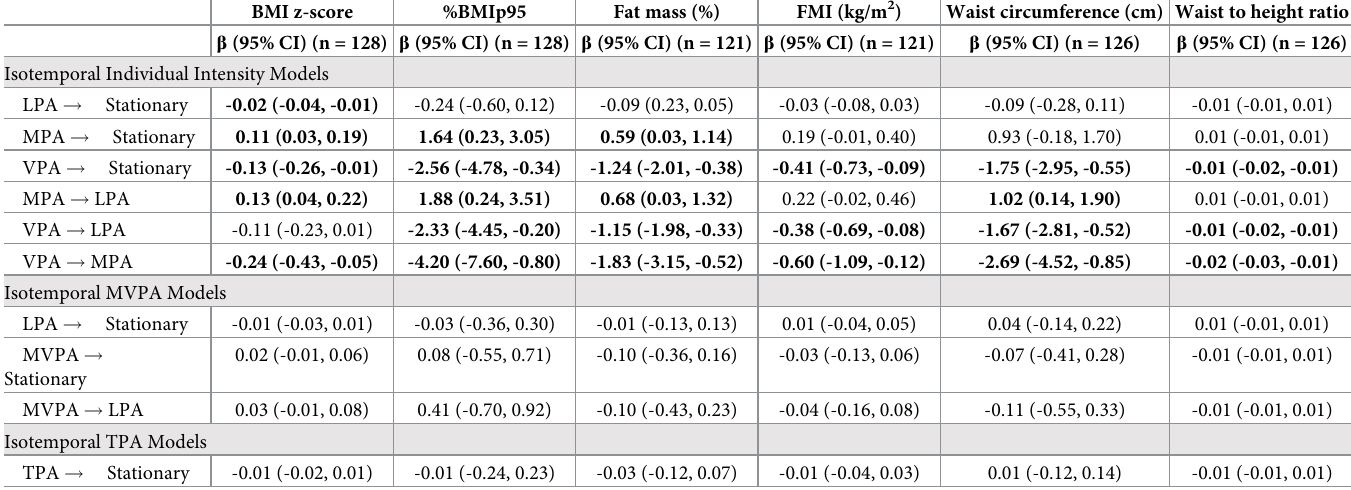
Table 2. Isotemporal substitution of movement behaviors with adiposity health indicators in preschool children with overweight and obesity participating in the baseline assessment of the TX CORD secondary prevention study (N = 131).